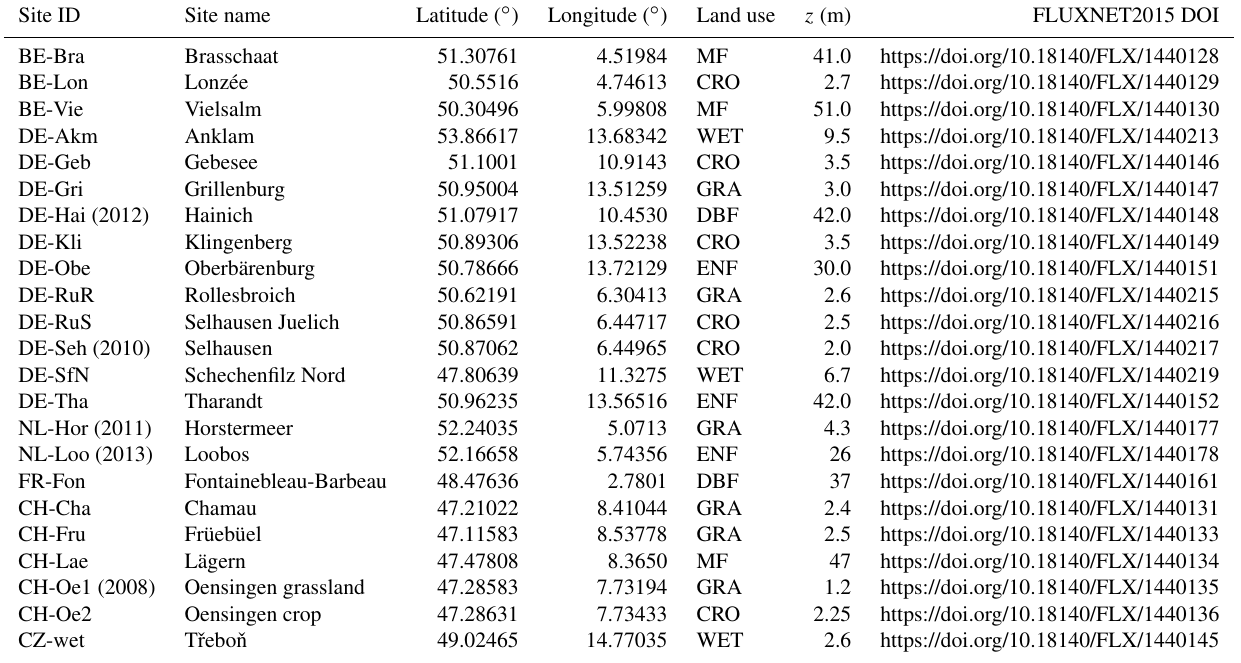
Table 1. Overview of eddy covariance sites used to compute z 0 . The following abbreviations for land use types are used: DBF – deciduous broadleaf forest, ENF – evergreen needleleaf coniferous forest, MF – mixed forest, CRO – croplands, WET – permanent wetlands, GRA –